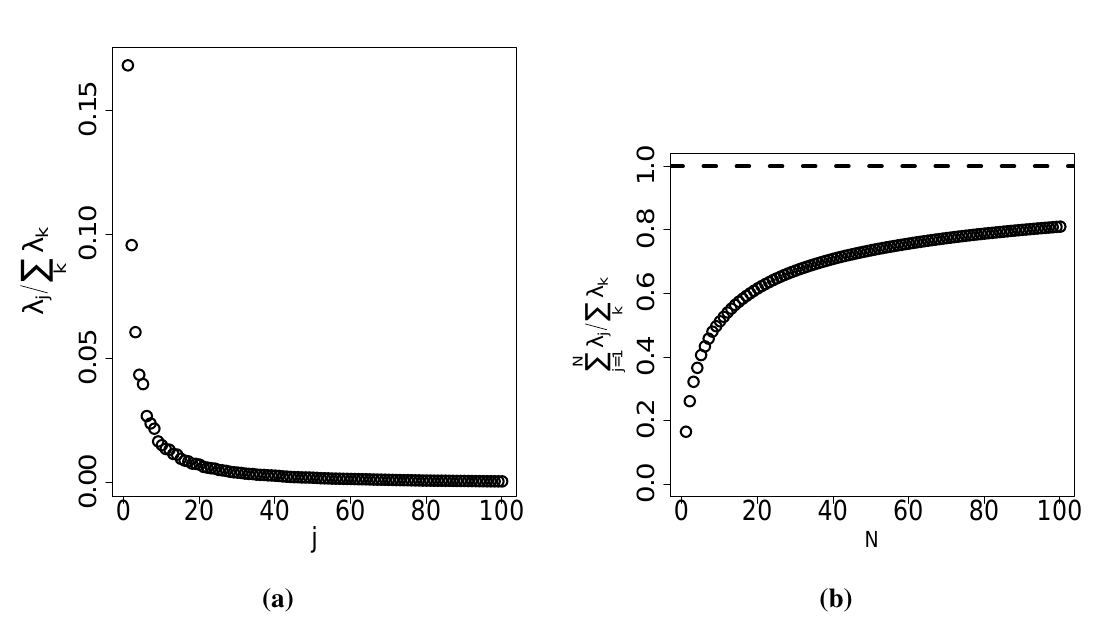
Figure 4. ( a ) POD eigenvalues of the preprocessed field ˜ u ; ( b ) cumulative energy versus the number of modes N